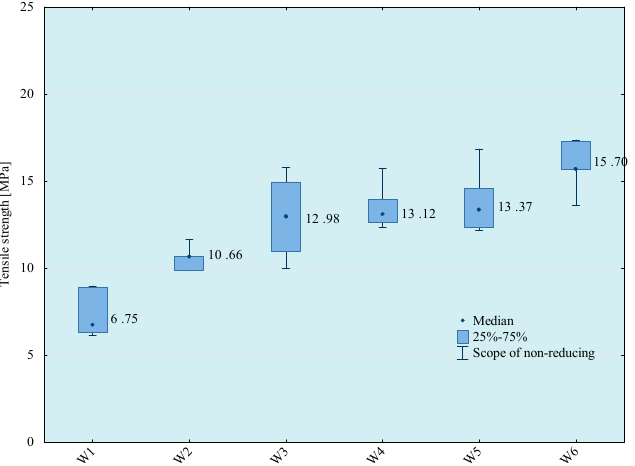
Figure 6. Tensile strength of E57/Z-1/CWZ-22/100:10:20 composition depending on the mixing method.